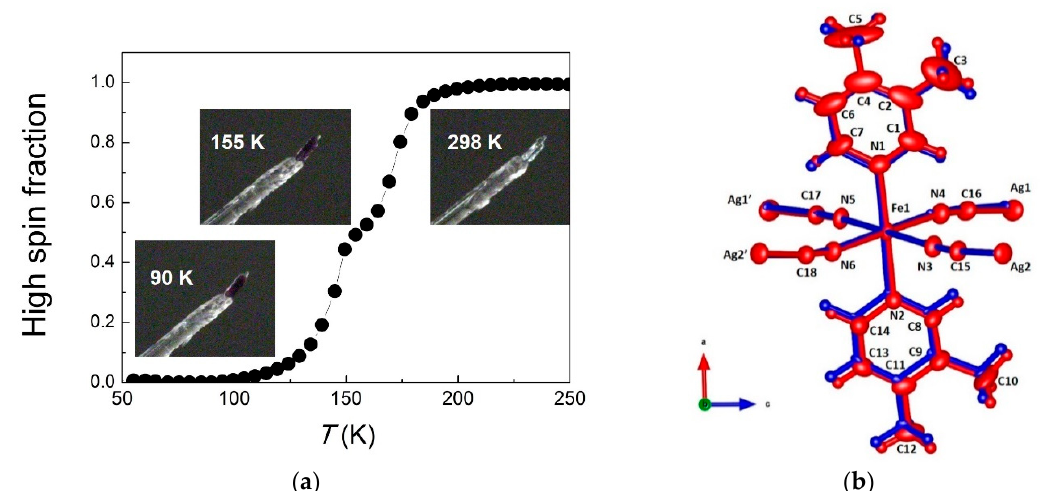
Figure 1. ( a ) Temperature dependence of the fraction of centres in the high-spin state for Fe(3,4-dimethyl-pyridine) 2 [Ag(CN) 2 ] 2 deduced from magnetic susceptibility measurements (from Reference [16]) and photographs of the crystals at the temperatures of the structural determination. ( b ) Representation of a fragment of the structure of Fe(3,4-dimethyl-pyridine) 2 [Ag(CN) 2 ] 2 at room temperature (red) and 90 K (blue) containing its asymmetric unit and atom numbering (excepting H atoms, for clarity). Thermal ellipsoids of non-hydrogen atoms are represented at 40% probability (H atoms are represented as spheres with arbitrary radius).